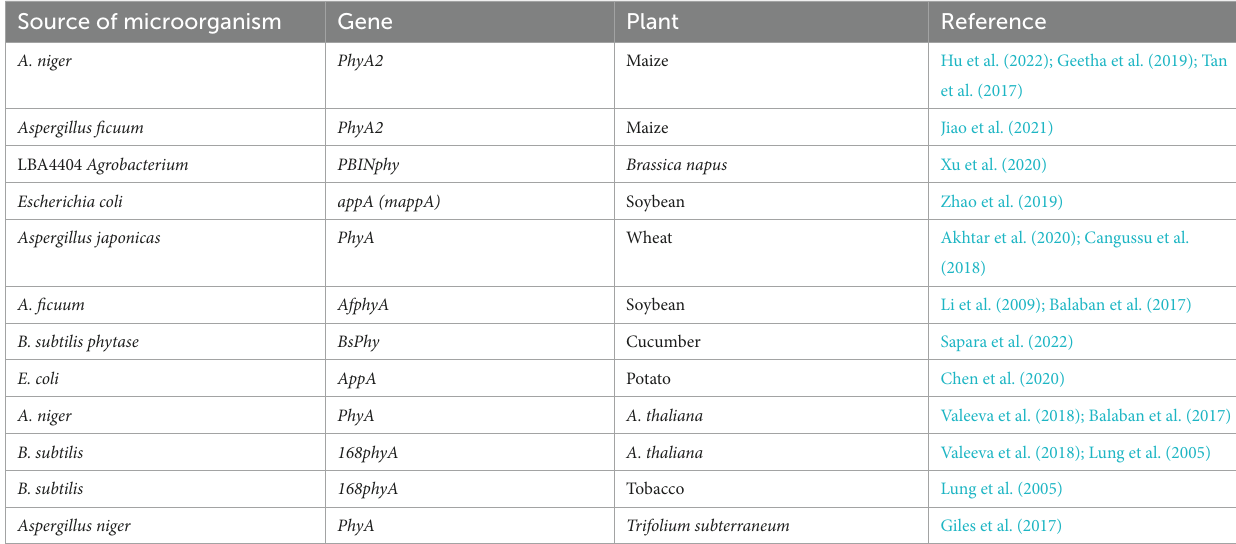
TABLE 2 Transgenic plants developed in response to positive outcomes.